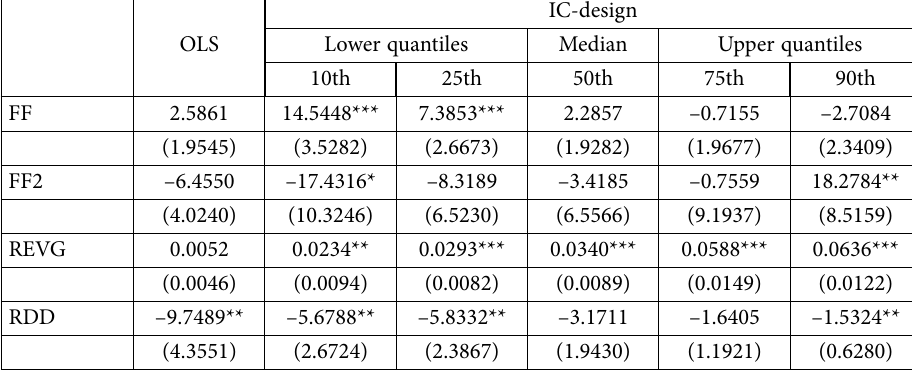
Table 15. OLS and QR results for IC-design and IC -manufacturing using